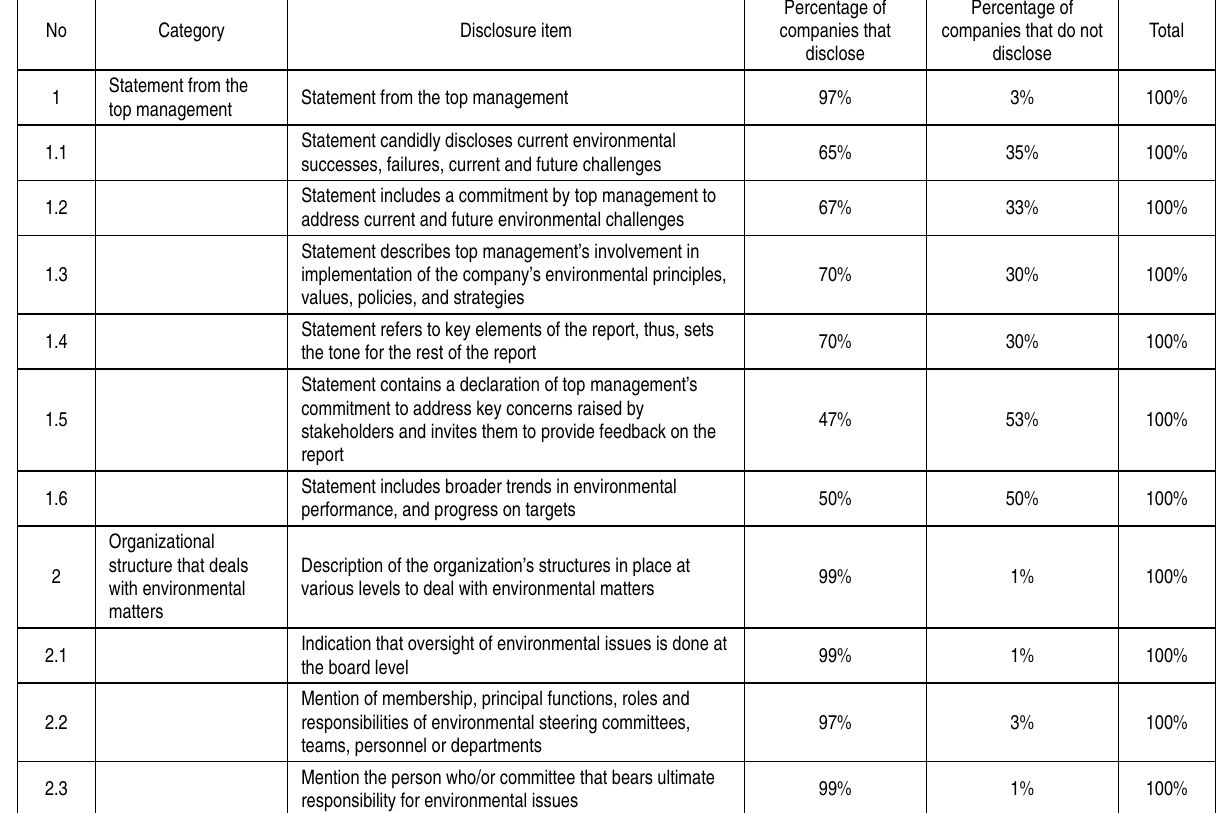
Table 1. Disclosure of a statement from top management and the organizational structure that deals with environmental